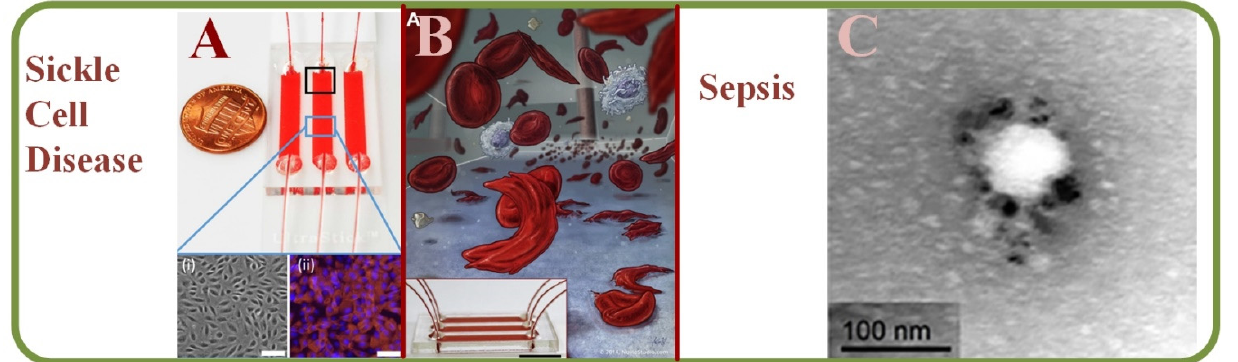
Figure 13. ( A ) Endothelium-on-a-chip for probing the RBC adhesion to heme-activated endothelial cells to reflect clinical phenotype in sickle cell disease, including blood sample images [232]. ( B ) A SCD biochip for RBC adhesion assay monitoring, including the SCD RBCs suspension [230]. ( C ) An image showing the plasma-derived extracellular vesicles on the RBCs deformability in polymicrobial sepsis [234].